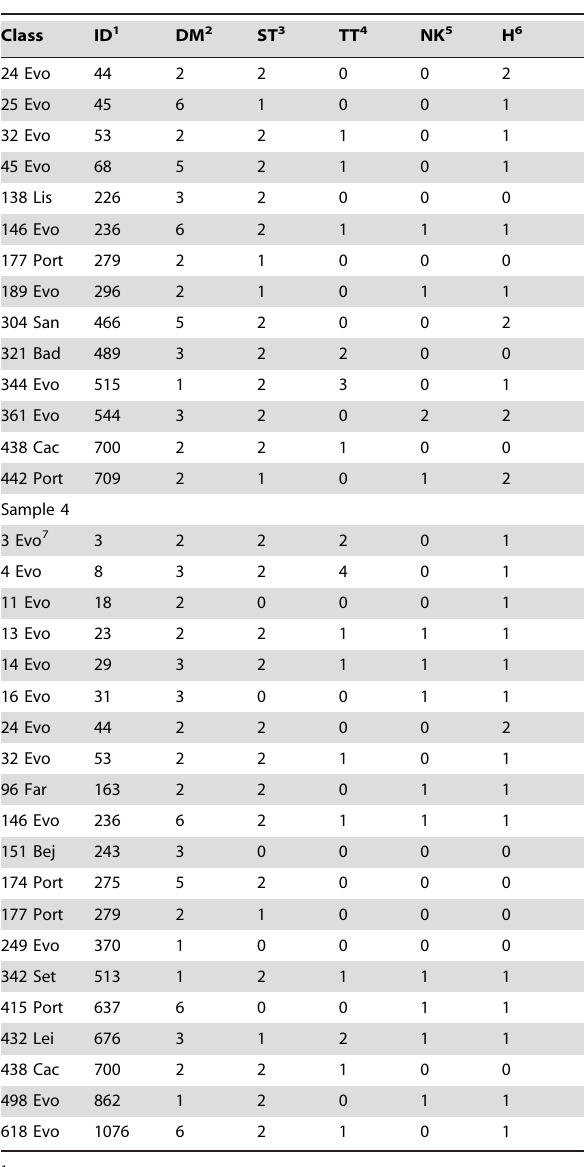
1 ID=specimen number in the ESPRIT database [45]. 2 DM=decorative motif. 3 ST=structure. 4 TT=tattoo straps. 5 NK=neck. 6 H=head. 7 Abbreviations to the right of the class numbers refer to the geographic provinces shown in Fig.